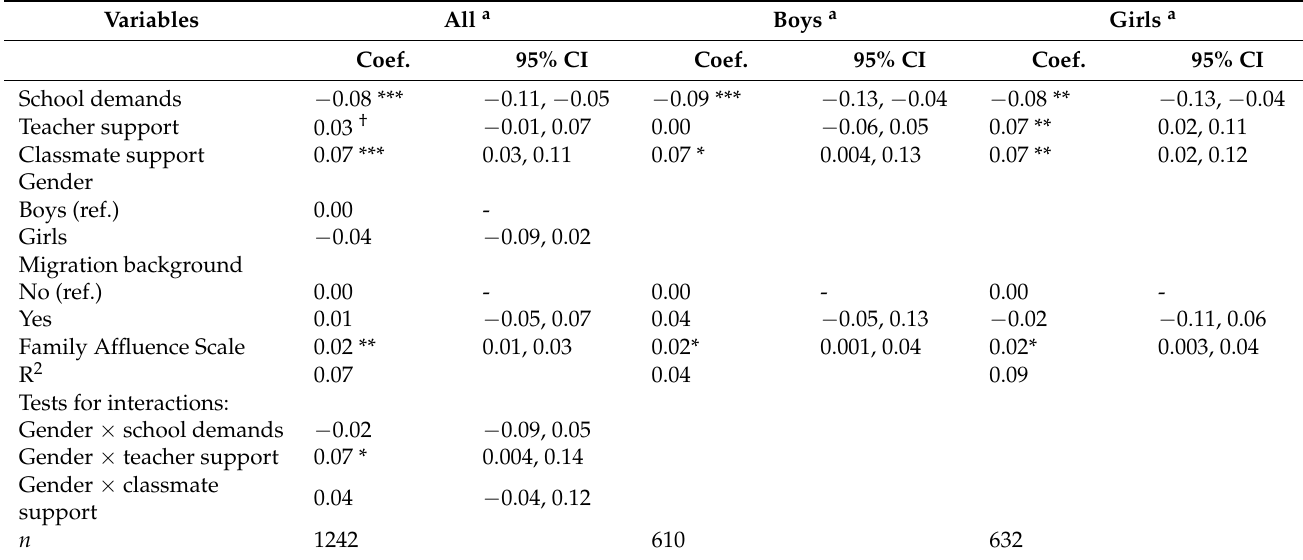
Table 2. Results from the linear probability models of excellent self-rated health among grade seven students ( n = 1242, distributed over 70